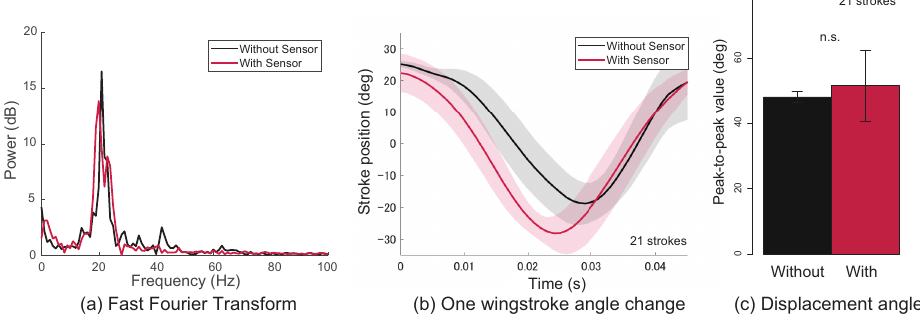
Figure 6. Evaluation of the effect of flapping when the sensor is attached to a dragonfly. ( a ) Flapping frequency, ( b ) the flapping displacement angle change of one wingstroke, and ( c ) the peak-to-peak value of the flapping angle.